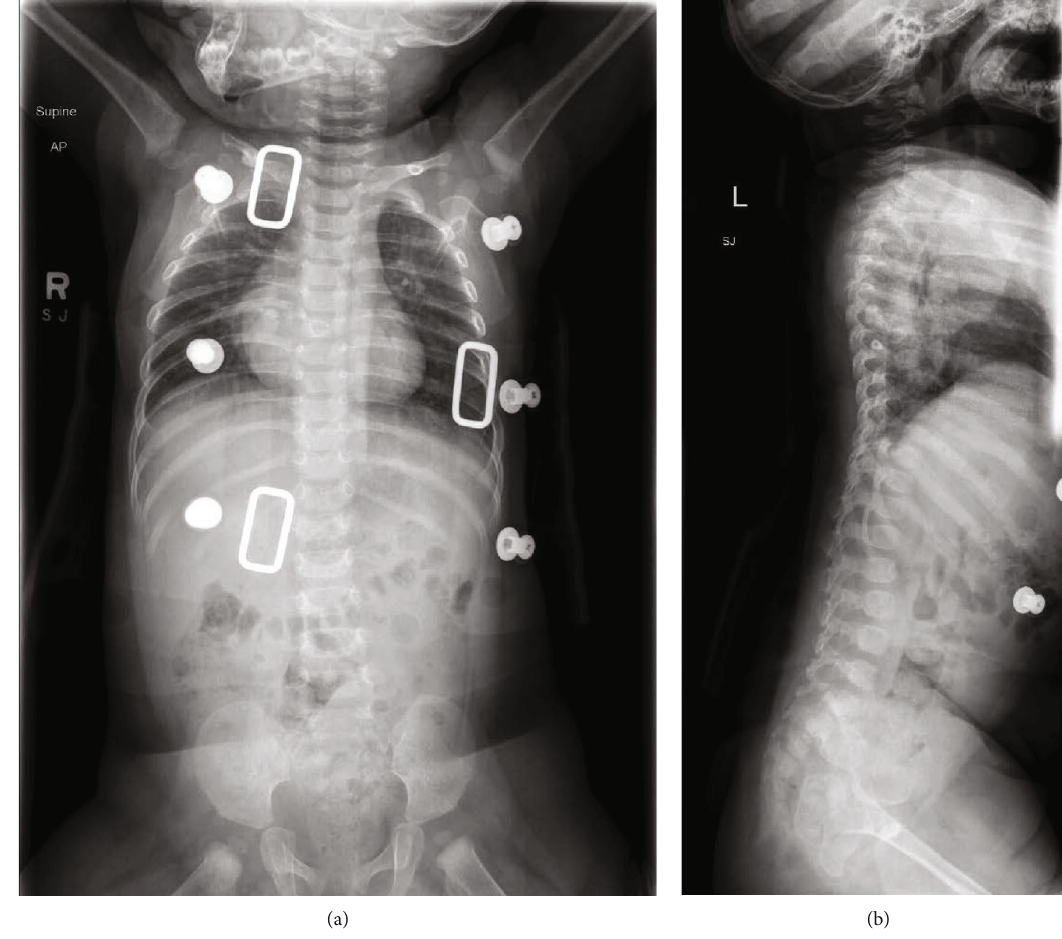
Figure 5: (a, b) Postoperative AP spine and sagittal radiographs with no evidence of residual tumor or further progression of